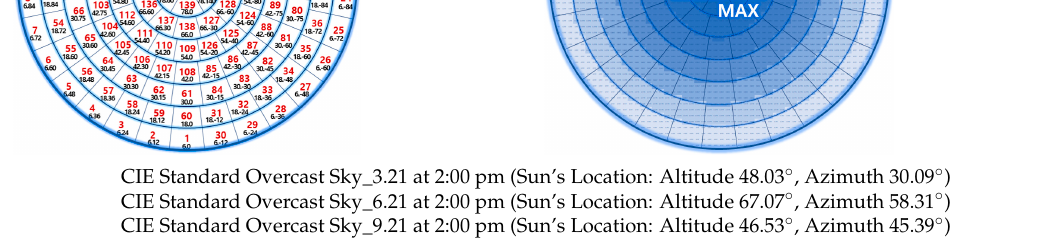
Table 8. Sky luminance distribution of CIE standard clear sky.